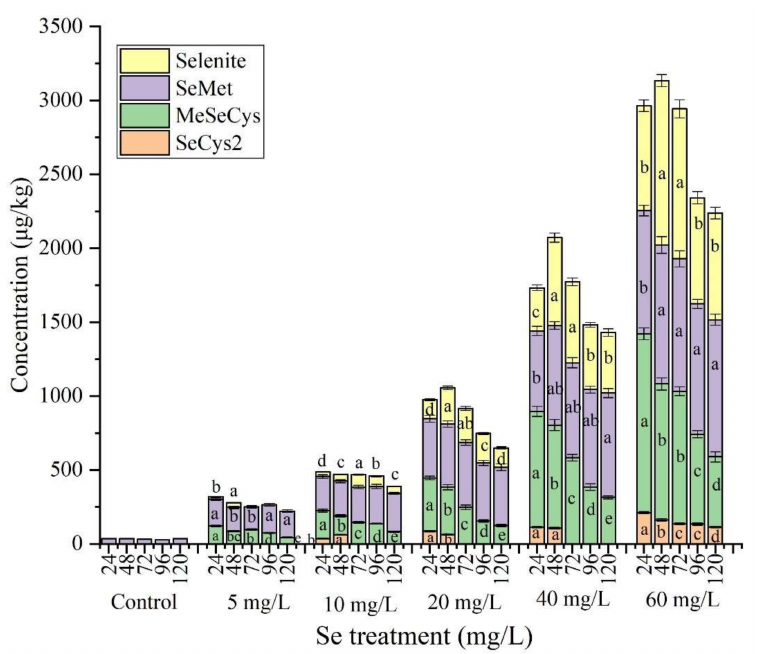
Figure 2. Concentration of Se species under different treatment during the germination. Different letters are used to show significant differences at various treatments ( p < 0.05) in the same Se species (same color) under different Se concentration treatment,